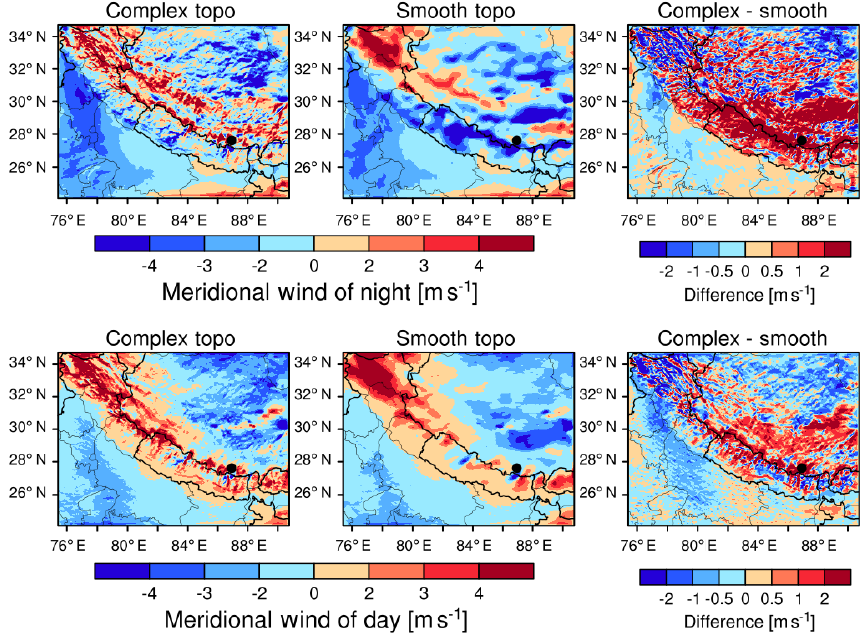
Figure 13. Spatial distributions of meridional wind speed averaged within 500m above the ground for day and night during 1–20 April 2016 from the simulations with the complex and smooth topographies. The difference between the two is also shown. Nighttime is defined as 21:00–06:00 local time, and daytime is defined as 09:00–18:00 local time. Positive value denotes a southerly, and negative value denotes a northerly. The results averaged within 2km above the ground are consistent.